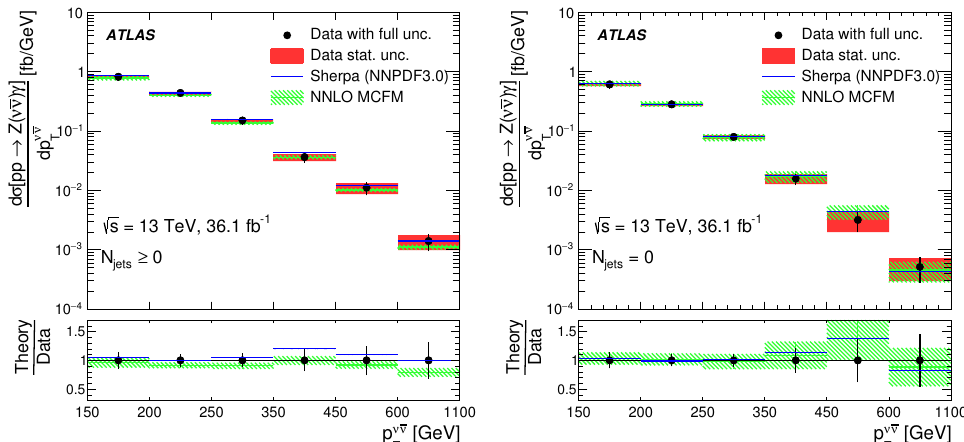
Figure 5 . The measured (points with error bars) and predicted di(cid:11)erential cross sections as a function of p (cid:23) (cid:22) (cid:23) for the pp Z ( (cid:23) (cid:22) (cid:23) ) (cid:13) process in the inclusive N jets 0 (left) and exclusive N jets = 0 T ! (cid:21) (right) extended (cid:12)ducial regions. The error bars on the data points show the sum in quadrature of the statistical and systematic uncertainties. The Mcfm NNLO predictions are shown with shaded bands that indicate the theoretical uncertainties described in section 5.4. For the Sherpa predictions, systematic uncertainty is not considered, and the statistical uncertainties arising from the size of the MC samples are too small to be visible. The lower plots show the ratios of the SM expectation to the measured values (shaded bands), with the error bars on the points showing the relative uncertainties in the experimental measurements. The bin size varies from 50 GeV to 500 GeV.